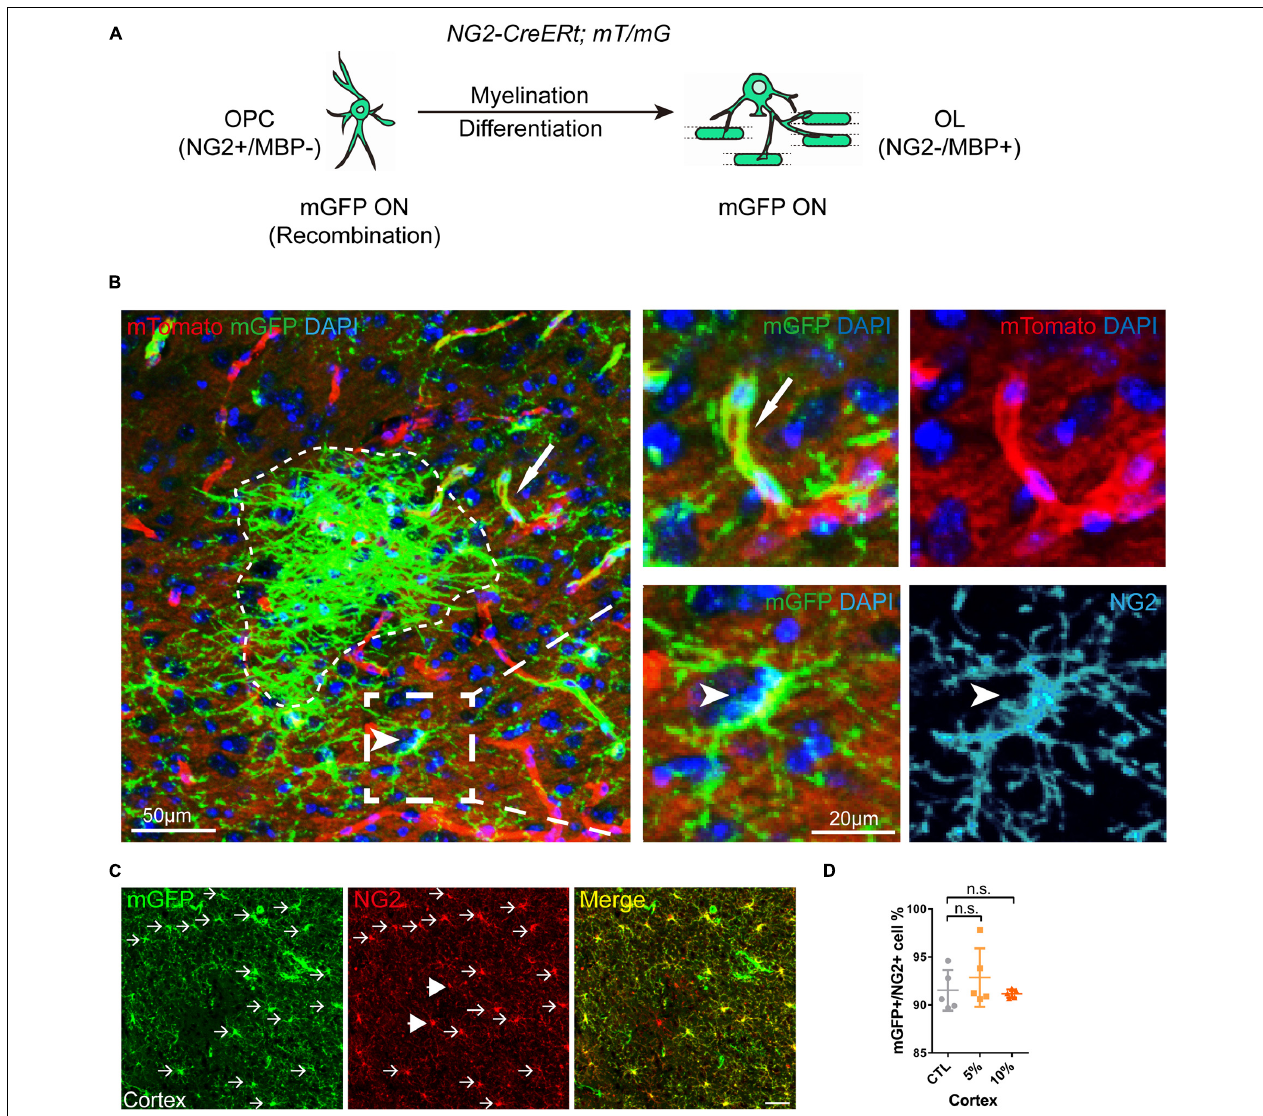
FIGURE 2 | Visual representation of the mGFP positive cells in NG2-CreERt; mT/mG mice. (A) Schematic illustration showing the mGFP expression pattern in the NG2-CreERt; mT/mG mice. (B) Representative images showing mGFP (green)/NG2 (cyan) double positive OPCs (arrowhead), mGFP + NG2- new OLs or myelin sheaths (dotted irregular line) and mGFP + pericytes (arrows) attached to mTomato positive (red) blood vessels. (C) Immunostaining of NG2 showing the NG2/mGFP double positive cells (arrows) and NG2 + mGFP- cells (arrowheads). Scale bar 50 µ m. (D) Quantification of the percentage of mGFP (green) positive cells in the NG2 (red) positive cells (OPCs) (n.s. p = 0.45, n = 5).